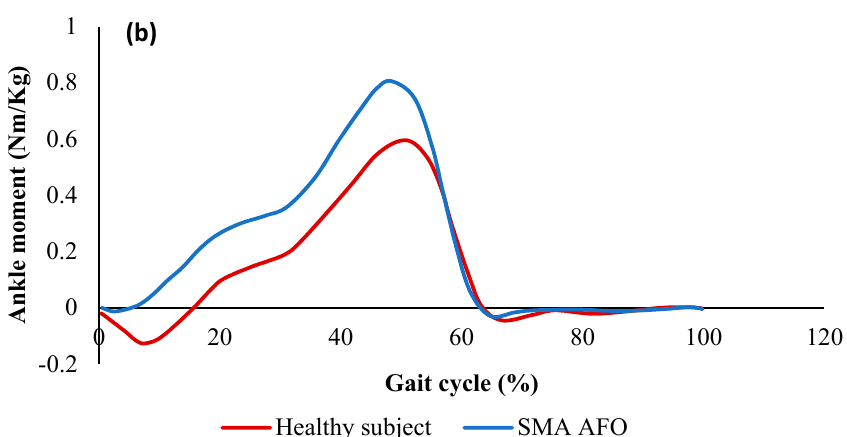
Figure 22. ( a ) Ankle angle (mean value) over the gait cycle for the healthy subject, the patient without the brace, with the conventional brace, and with SMA AFO, and ( b ) moment profiles over the gait cycle for the healthy subject and patient with SMA AFO [51].